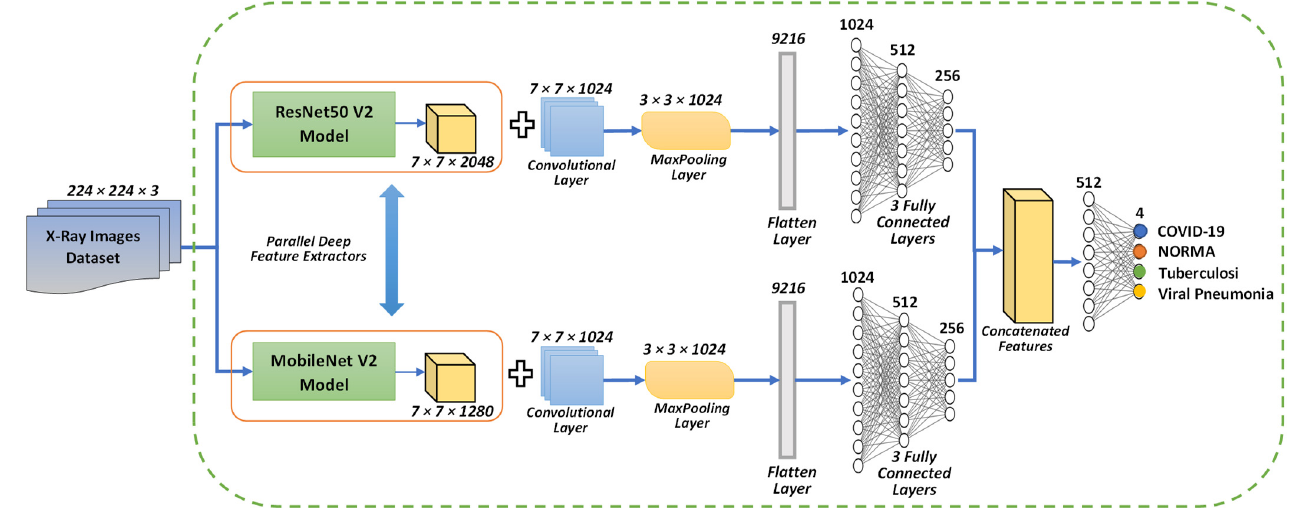
Figure 3. The architecture of the proposed concatenation model based on the modified ResNet50 V2 and MobileNet V2 models. Table 11. The detailed architecture of the proposed concatenation model based on the modified ResNet50 V2 and MobileNet V2 models.